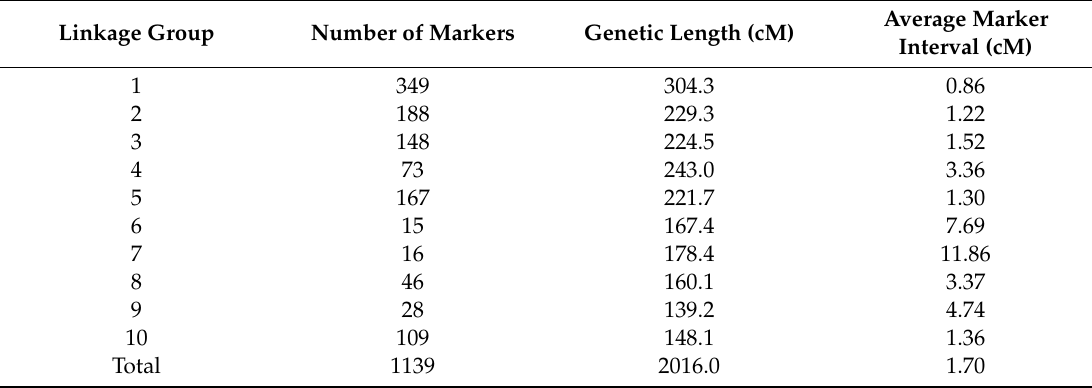
Table 2. Summary statistics of the linkage